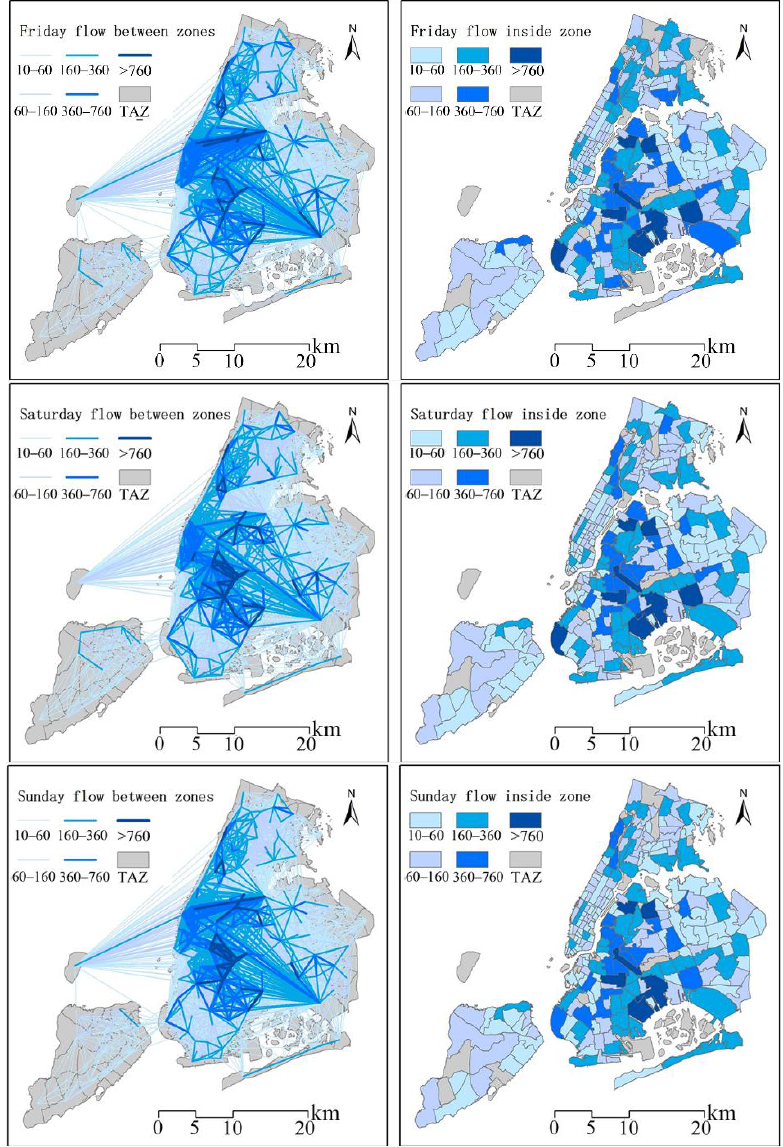
Figure A4. Travel spatial structure diagram from Monday through Sunday in New York.